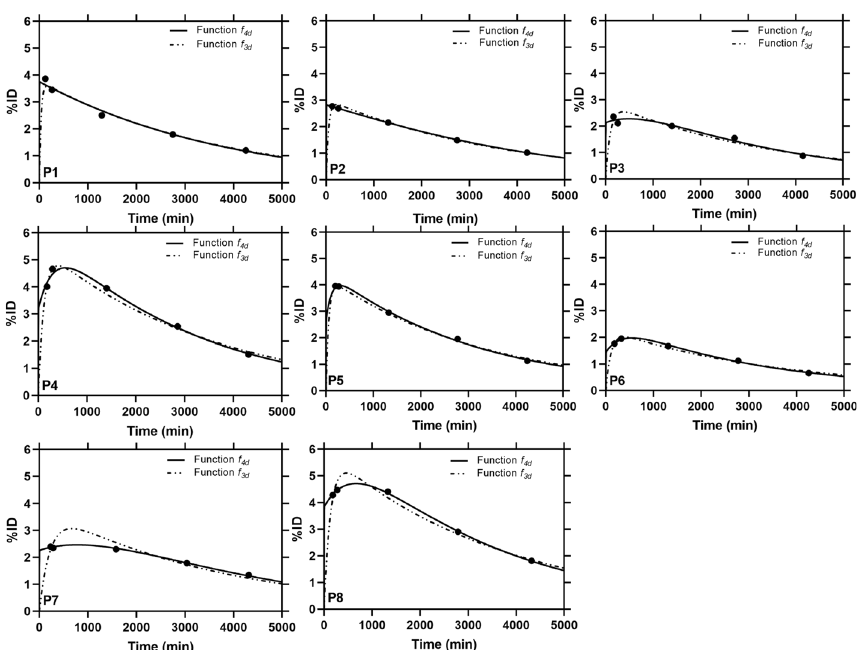
Fig. 1 Time-activity data and ATP fit curves obtained using function f 4 d , which is chosen as most supported by the data using the presented MS–NLME method. Function f 3 d is shown for comparison, as it is the function with the highest Akaike weight from the group of functions with three and five